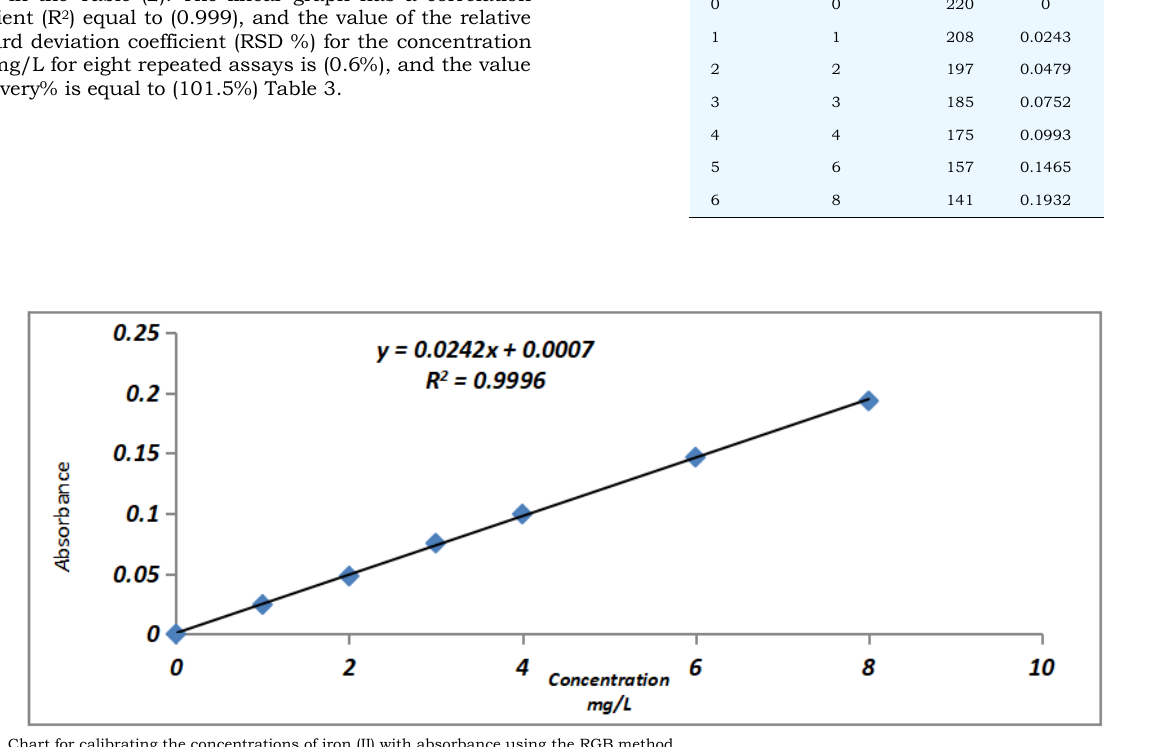
Table 3 Optimum Conditions for RGB Method Analytical values Values Limits of Applicability of the (Beer-Lambert) Law (mg/L) 8-Jan Detection limit ( mg/L) 0.2 (Recovery%) for a concentration of (4 mg/L) for 10 assays 101.50% (RSD%) for concentration (4 mg/L) for 10 assays